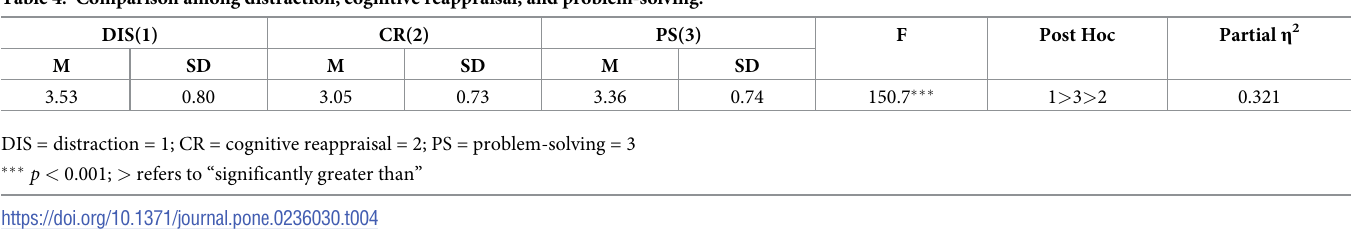
Table 4. Comparison among distraction, cognitive reappraisal, and